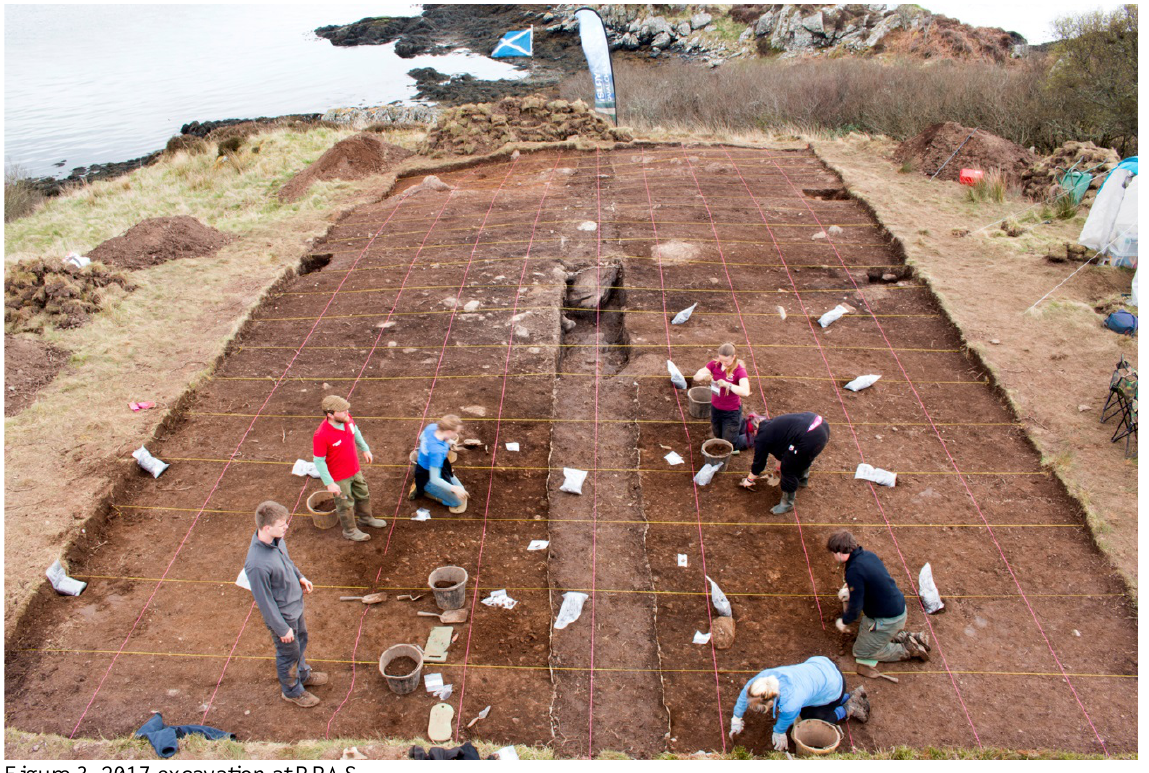
Figure 3. 2017 excavation at